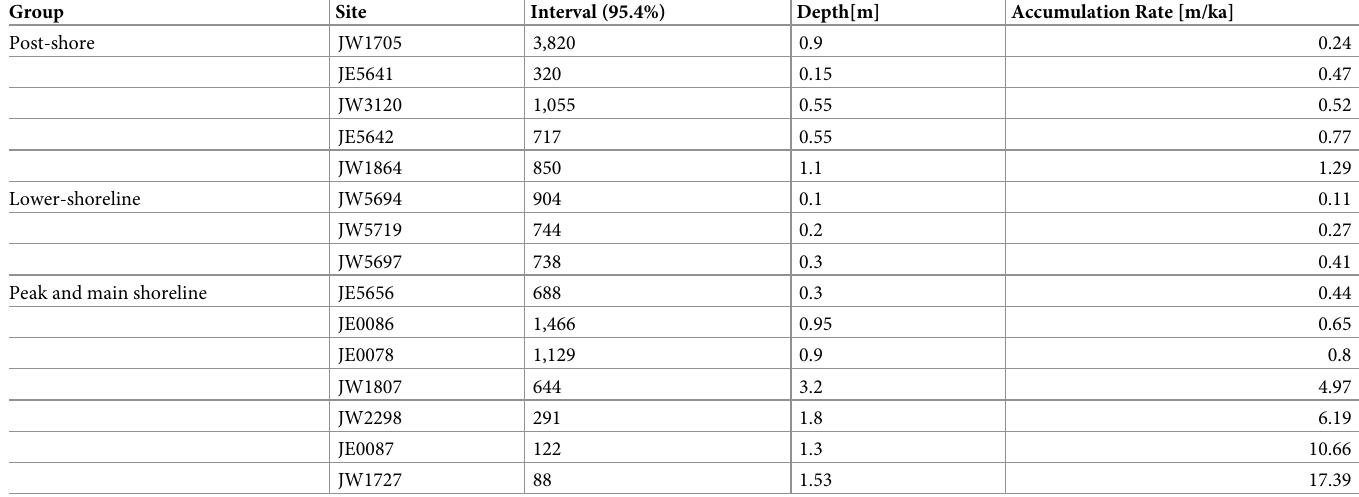
Table 2. Depth of deposit and accumulation rates in m per thousand years (ka) based on the difference between depths of lowest and highest radiocarbon samples within each site. Group